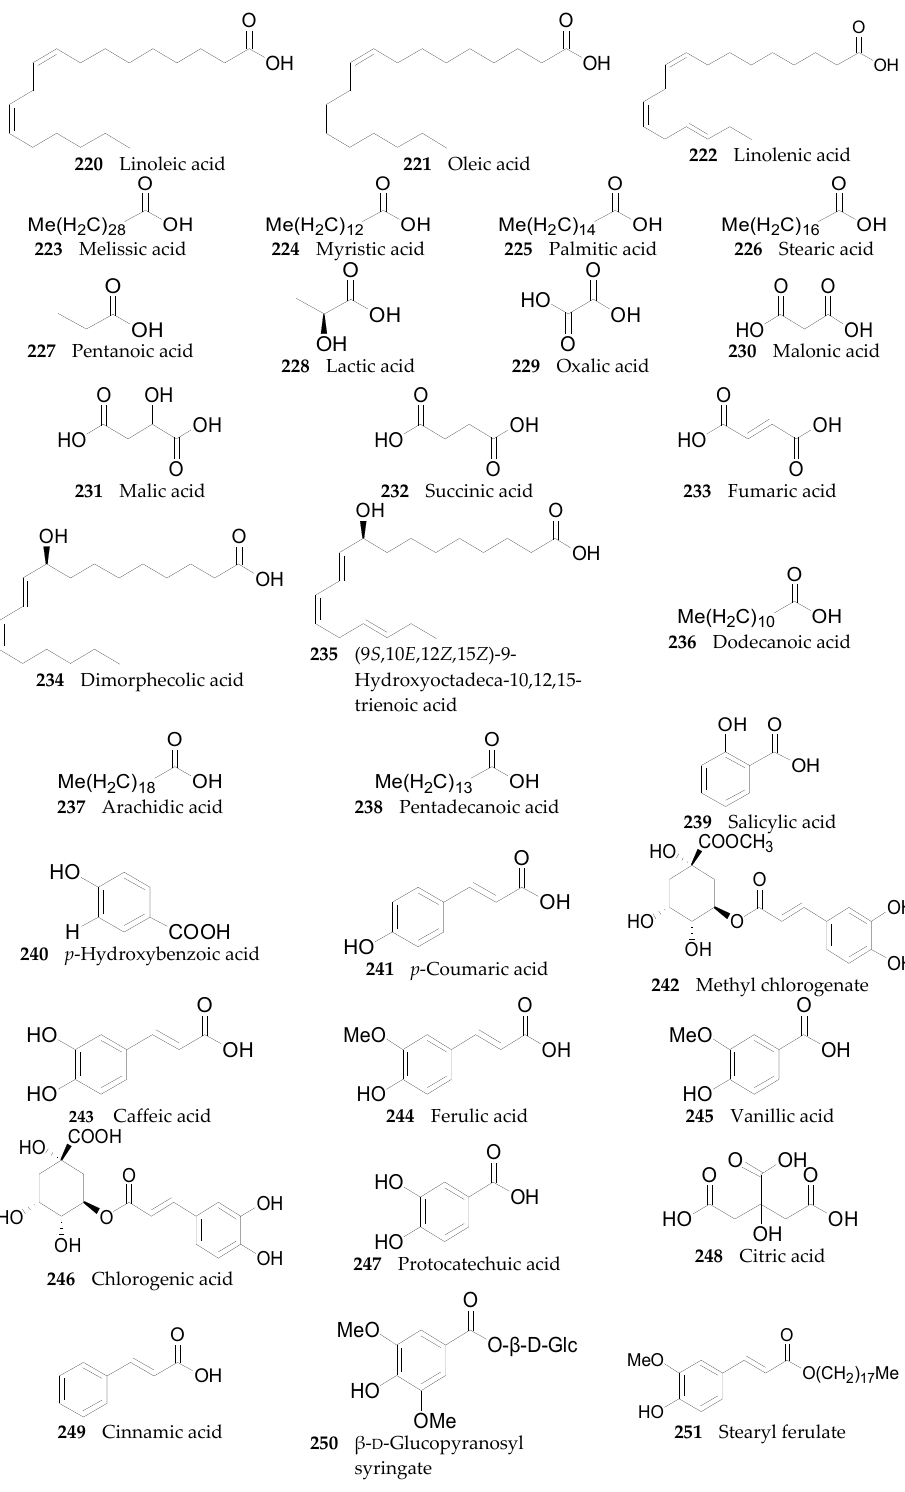
Figure 18. Chemical structures of compounds 220 – 251 .